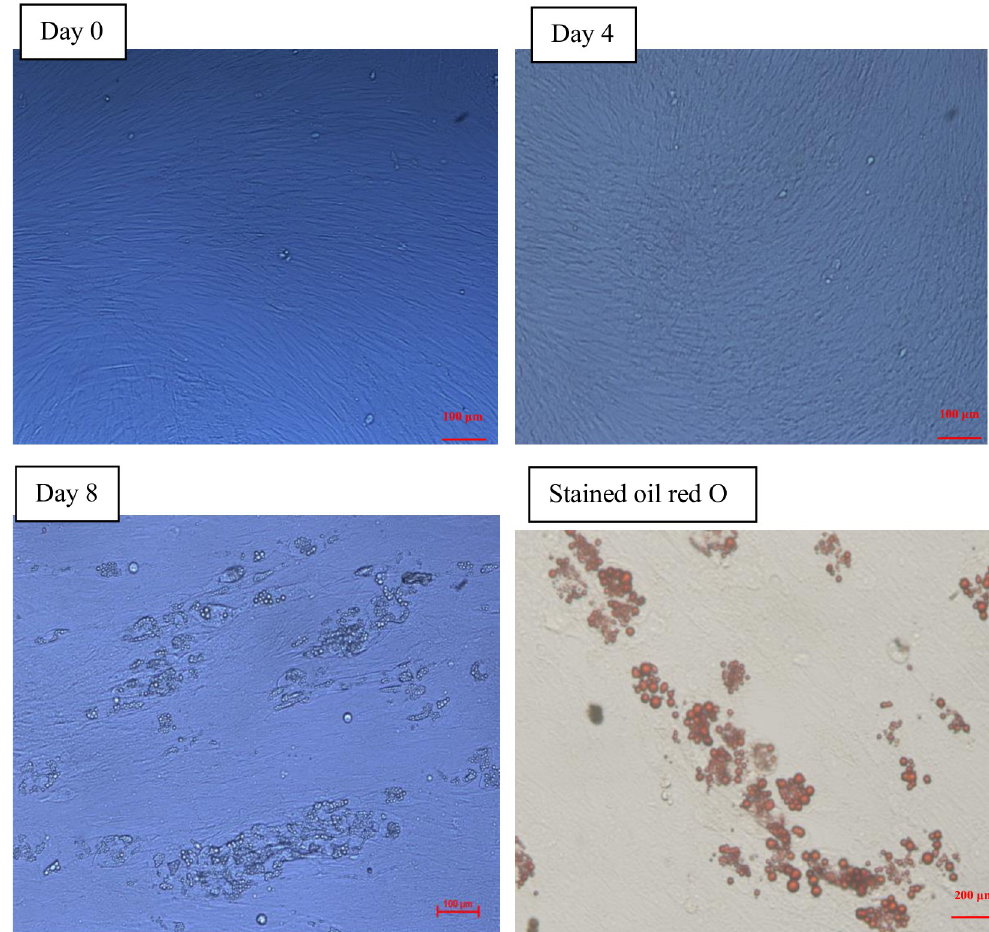
Fig 1. In vitro intramuscular preadipocyte differentiation. Intramuscular preadipocytes were obtained from the longissimus doris tissue of three three-day-old Chinese Guizhou Congjiang pigs and collected at three differentiation stages: Day 0, day 4, and day 8. Photos show enlarged adipocytes during differentiation (day 0, day 4, day 8; day 8 with Oil Red O